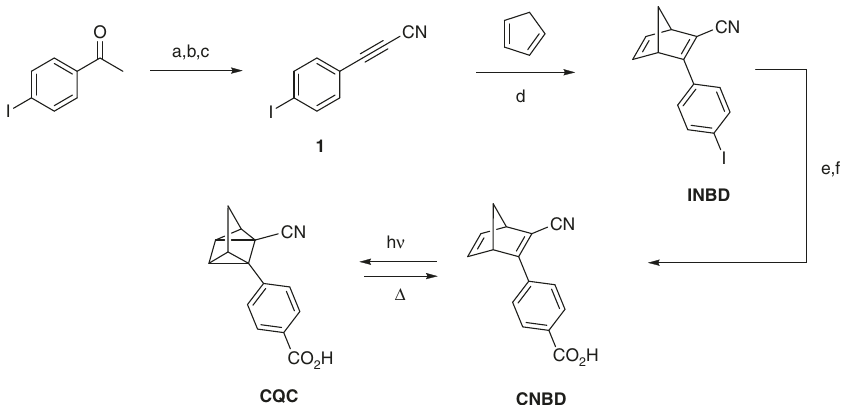
Fig. 6 Synthetic sequence for CNBD-CQC photoswitch couple. Conditions: ( a ) POCl 3 , DMF, 3 h; ( b ) I 2 , NH 3(aq) , CHCl 3 , 3 h; ( c ) NaOH (aq) , THF, 4 h; ( d ) chlorobenzene, BHT, 120 °C, 20 h; ( e ) i PrMgCl . LiCl, THF, − 41 °C, 1 h; CO 2(g) , − 41 °C – RT, 16 h, followed by HCl